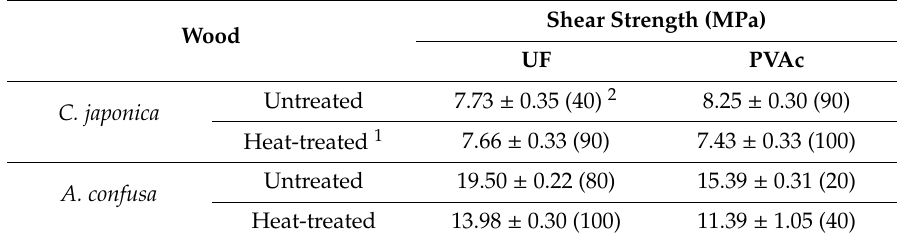
Table 1. Normal shear strength of untreated and treated Japanese cedar ( Cryptomeria japonica D. Don) and Formosa acacia ( Acacia confuse Merr.(Leguminosae)) wood with urea-formaldehyde resin (UF) and polyvinyl acetate (PVAc)